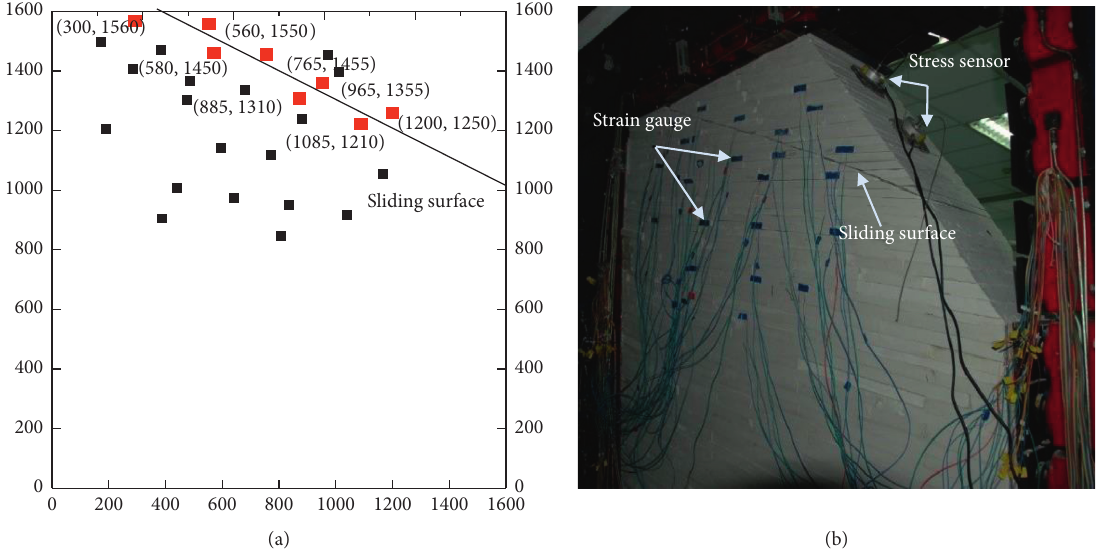
Figure 5: Image showing the solid position of the strain gauges.